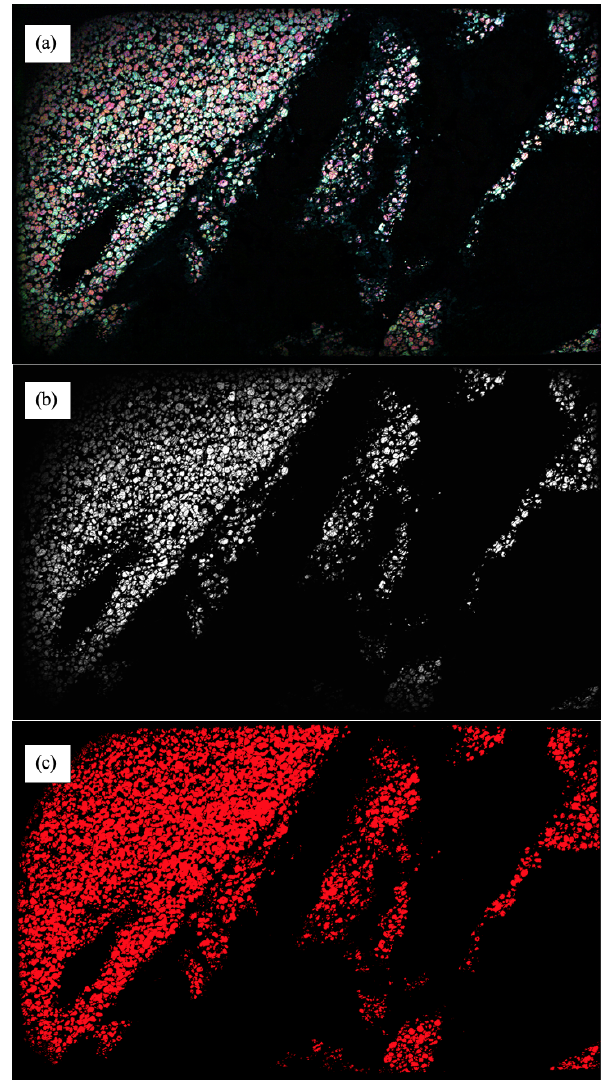
Figure 4. (a) Three-point band depth index (R: NdFD 1: ∼ 580nm; G: NdFD 2: ∼ 740nm; B: NdFD 3: ∼ 800nm) highlighting the monazites via light purple and blue pixels (saturation 400%); other minerals appear dark. (b) Single-band greyscale image derived from the three-point band depth index image by Eq. (3). The overall ab- sorption depth of the three features ( ∼ 580, ∼ 740, ∼ 800nm) de- termines the brightness of each pixel. (c) Classification image/map. The pixels from the greyscale that show absorption at all three fea- tures are identified as monazite (Nd) (red), and other minerals/ele- ments are not classified (black).